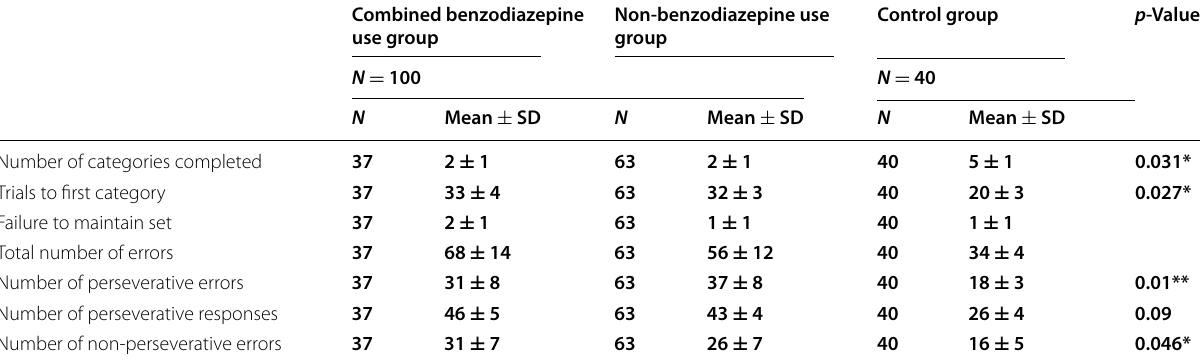
Table 7 Comparison between combined benzodiazepine and non-benzodiazepine use groups with control group regarding WCST